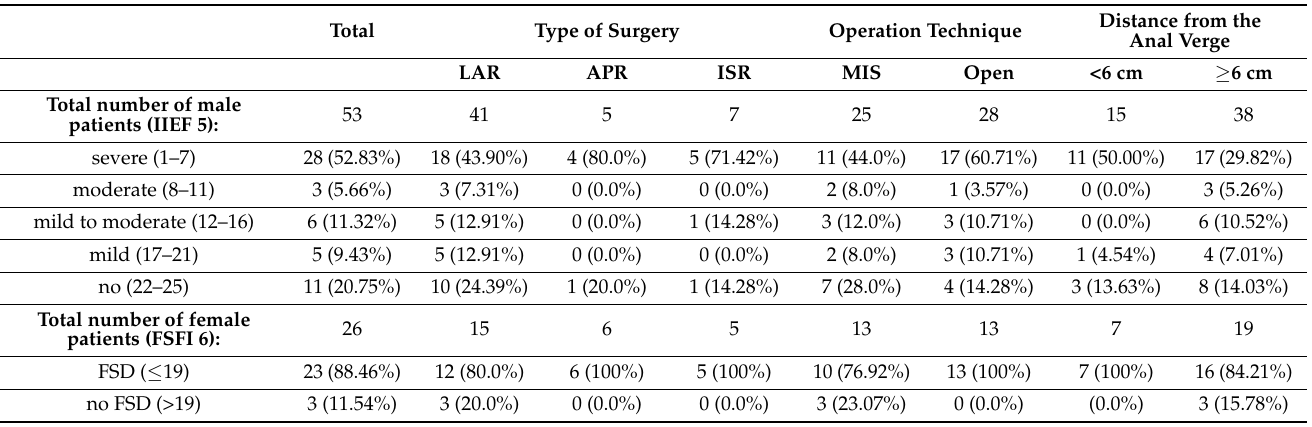
Table 2. Sexual dysfunction of entire cohort and depending on operation procedure or technique, either MIS or open surgery and distance from the anal verge.